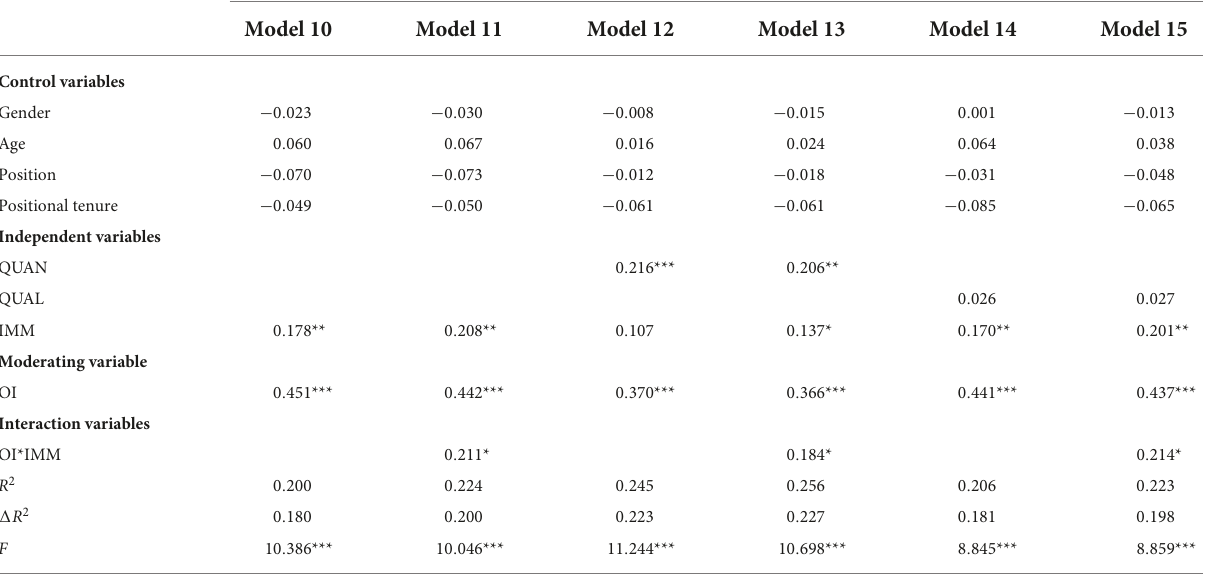
TABLE 4 Results of the multiple regression analysis of moderating effects ( N = 254).